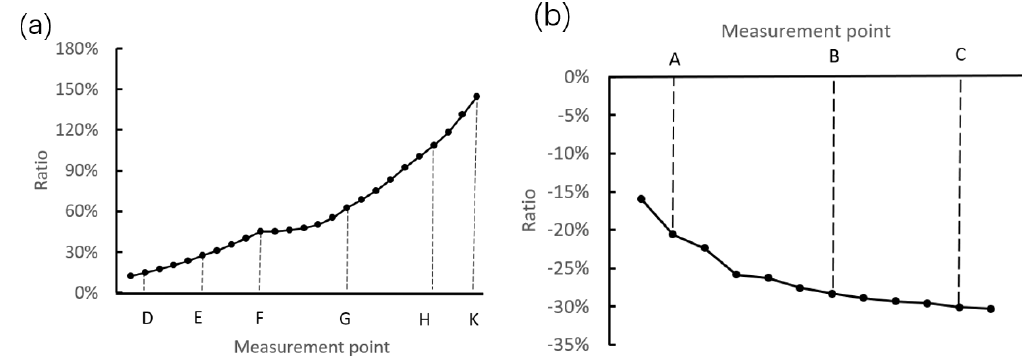
Figure 23. Displacement ratio of the interference assembly to the riveting assembly. ( a ) Along the side generatrix. ( b ) Along the upper generatrix.